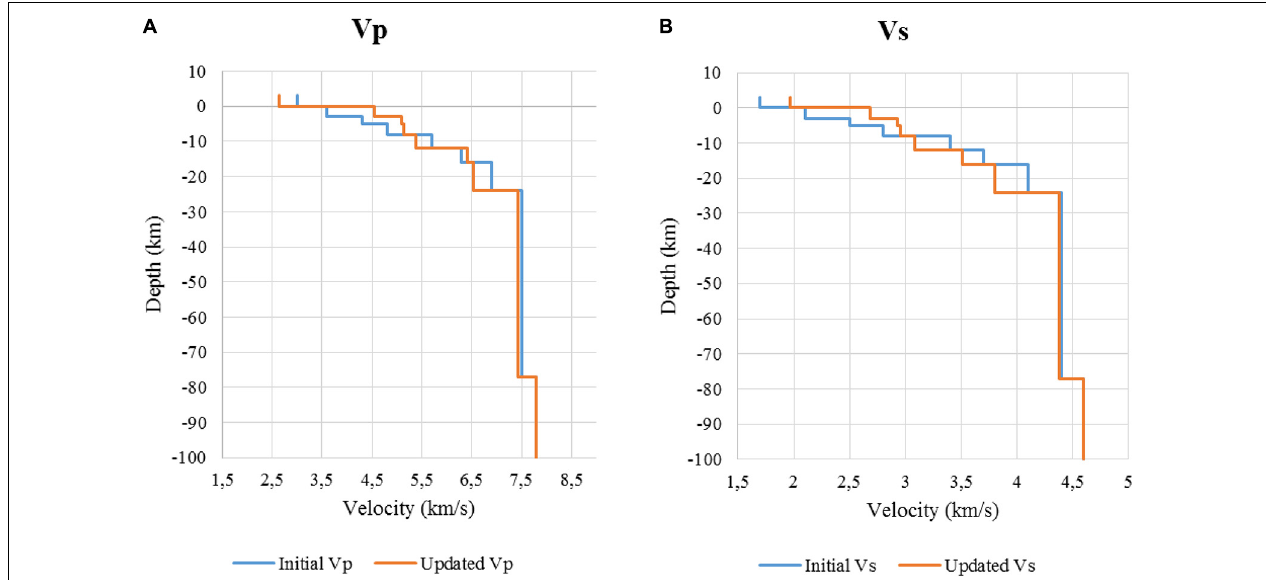
FIGURE 8 | Plot of the initial (A) P-wave and (B) S-wave 1D velocity of Kou09 model taken from Koulakov et al. (2009) (blue line) and the updated velocity model (Agu20) used in this study (orange line).